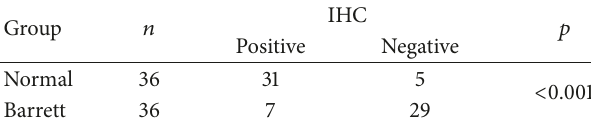
Table 4: Immunohistochemical results of Notch1.